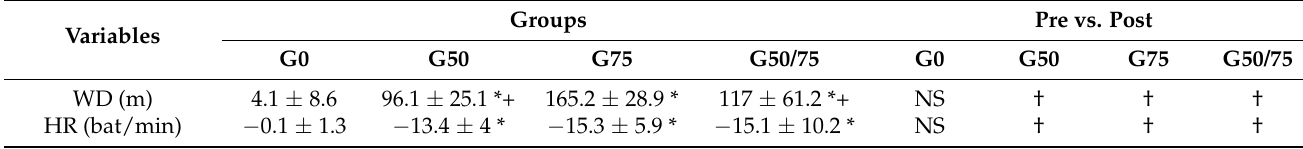
Table 4. Change in physical capacity measurements following the 12-week